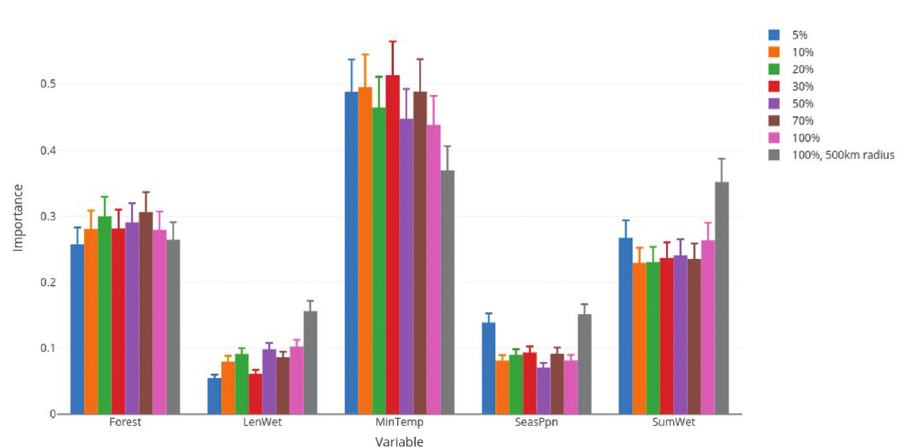
Figure 5. Importance of variables for Species Distribution Models (SDMs) of fall armyworm in the Americas and Africa. Colour codes indicate the percentage of the African distribution that was sub-sam- pled or the pseudo-absence selection background. Error bars are standard deviations of the results across all SDM techniques and distribution